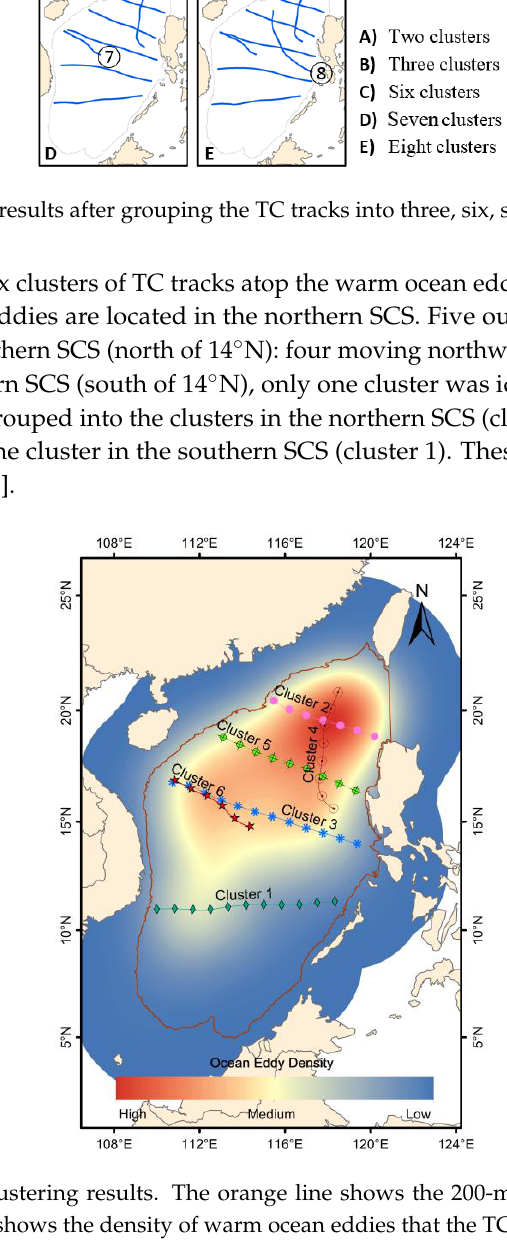
Figure 6. The FCM clustering results. The orange line shows the 200-m depth isoline of the SCS. The background color shows the density of warm ocean eddies that the TCs encountered. Table 3. Duncan’s pairwise comparison results.